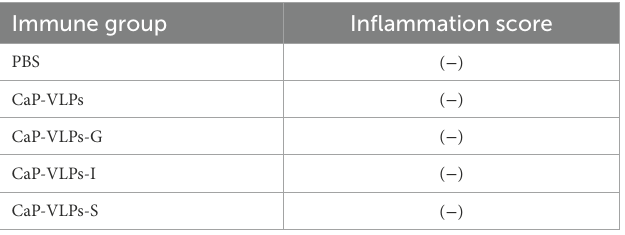
TABLE 1 H&E score of inflammatory infiltration of lung